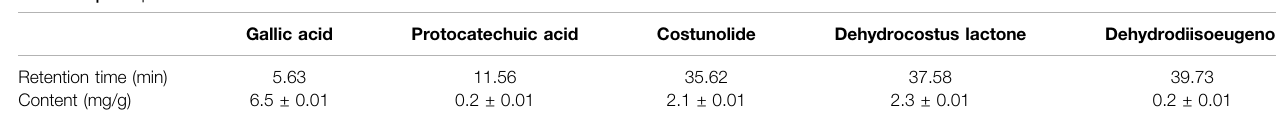
TABLE 2 | Compounds from